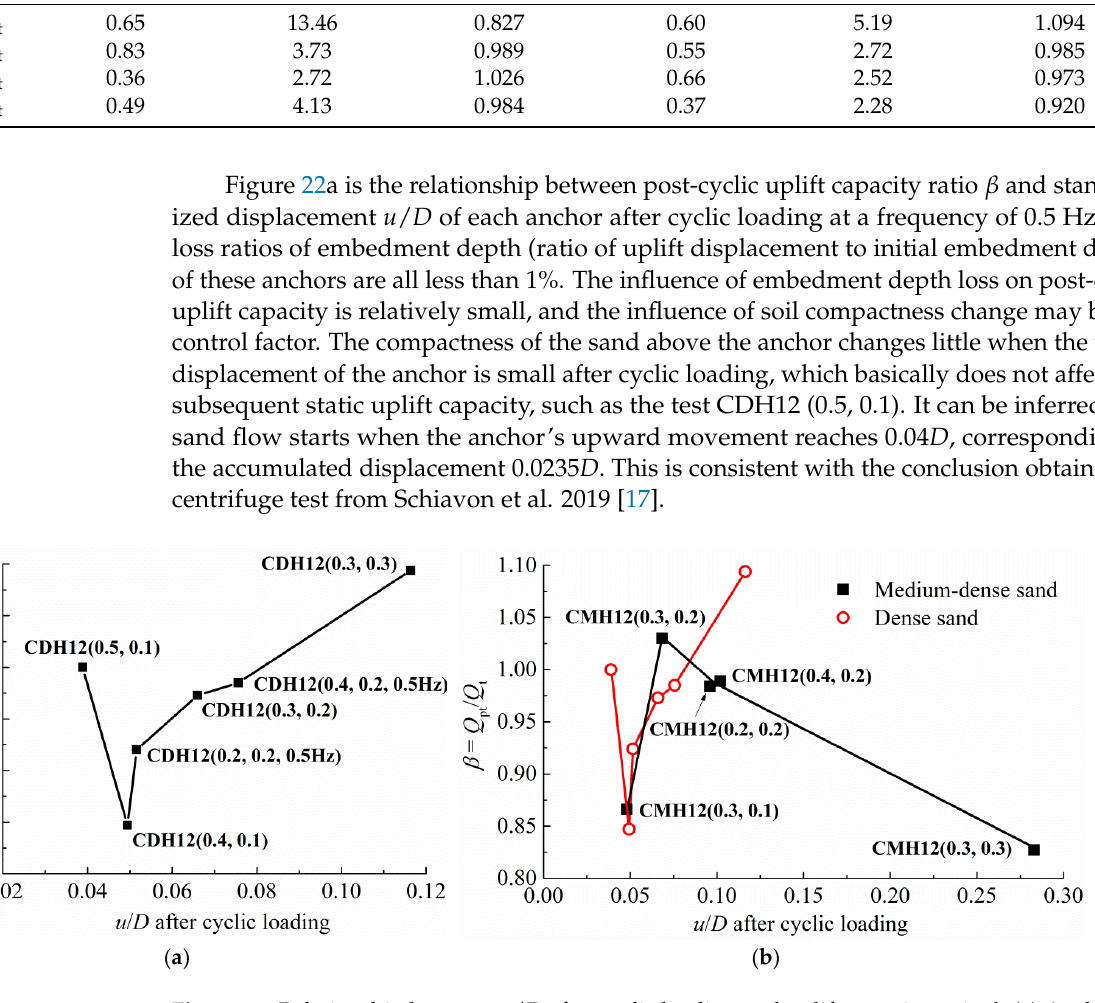
Figure 22. Relationship between u / D after cyclic loading and uplift capacity ratio β . ( a ) Anchors in dense sand; ( b ) comparison of anchors in medium – dense sand with those in dense sand. Figure 22b shows the relationship between β and u / D for the anchors in medium – dense sand and the comparison with dense sand. Anchor CMH12 (0.3, 0.1) produces an uplift displacement of 0.05 D after cyclic loading, corresponding to an embedment depth loss rate of 0.4%. The small embedment depth loss should have a slight influence on the post-cyclic uplift capacity Q pt ; however, the value of Q pt reduces by more than 13%, which indicates that cyclic vibration loosens the sand above the helix of anchor CMH12 (0.3, 0.1). Therefore, it is inferred that the sand above the helix may also flow into the gap at the bottom of the helix in the case that the anchor in medium – dense sand produces a small displacement under cyclic loading. Additionally, when the uplift displacement after cyclic loading of anchor CMH12 (0.3, 0.2) is greater than 0.07 D , the sand above the anchor re- covers to the pre-vibration state or is densified, and thus Q pt reaches the static uplift ca- pacity Q t , or an even higher magnitude. However, when the uplift displacement continues to increase, the sand on the helix is pulled tight enough to cause more sand flowing back to the helix ’s bottom gap, and the sand above the helix becomes loose again, such as for the anchors CMH12 (0.4, 0.2), CMH12 (0.2, 0.2) and CMH12 (0.3, 0.2). It can be seen from Figure 22b that the variation rule of the post-cyclic uplift capacity ratio in medium – dense sand with the standardized uplift displacement is different from that in dense sand. When the uplift displacement caused by vibration is about 0.05 D , the compactness of the sand above the helix in medium – dense sand and dense sand will be looser than that before cyclic loading. With the continuous increase in uplift displacement after cyclic loading, the sand above the helix returns to the initial state before vibration, and the uplift displacement required for medium – dense sand to return to the initial state is smaller than that of dense sand. However, the post-cyclic uplift capacity ratio of anchor in dense sand continues to increase with the increase in uplift displacement after cyclic loading. After the uplift displacement exceeds 0.1 D , Q pt still improves, indicating that the sand above the helix in dense sand is less likely to flow back to the bottom of the helix than that in medium – dense sand. 5. Conclusions A series of reduced-scale cyclic loading model tests of a single-helix anchor in sand with different compactness have been carried out, and the effects of anchor embedment ratio and cyclic loading parameters on the accumulated displacement, the development of axial stiffness and the post-cyclic monotonic uplift capacity have been analyzed. The correlation of post-cyclic monotonic uplift capacity ratio and post-cyclic displacement and